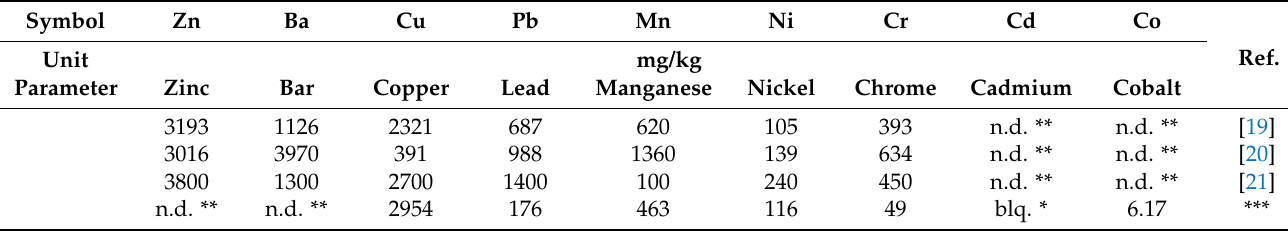
Table 2. The heavy metal content of MSWIBA.